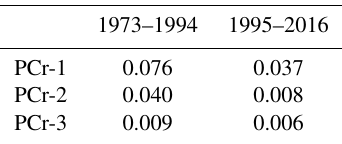
Table 4. Estimated probability of having very large fires (